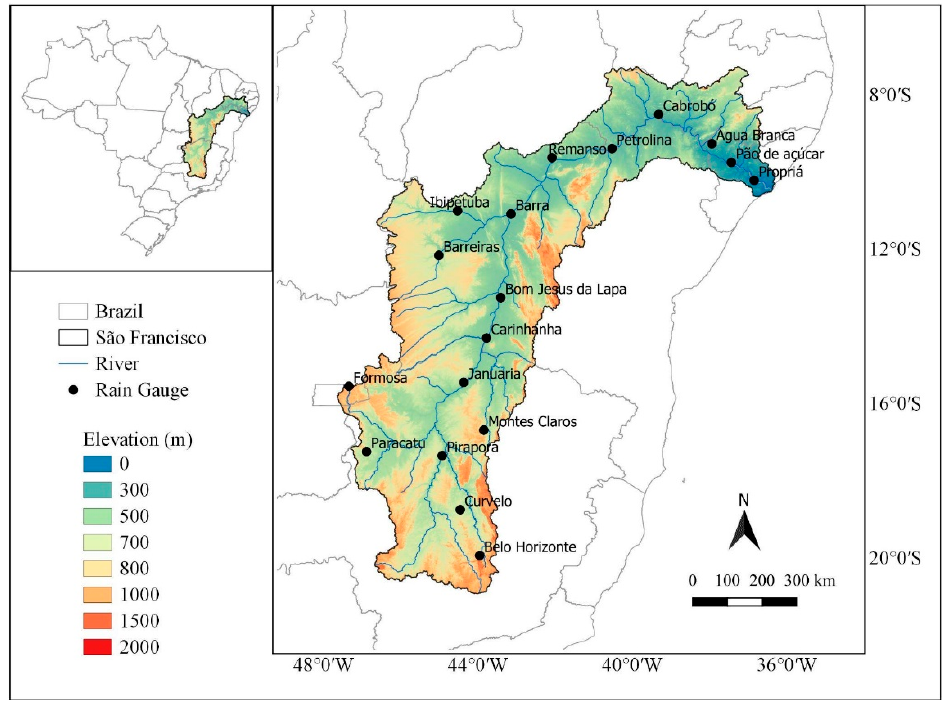
Figure 1. Location and topography of the São Francisco River basin region and rain gauge stations.